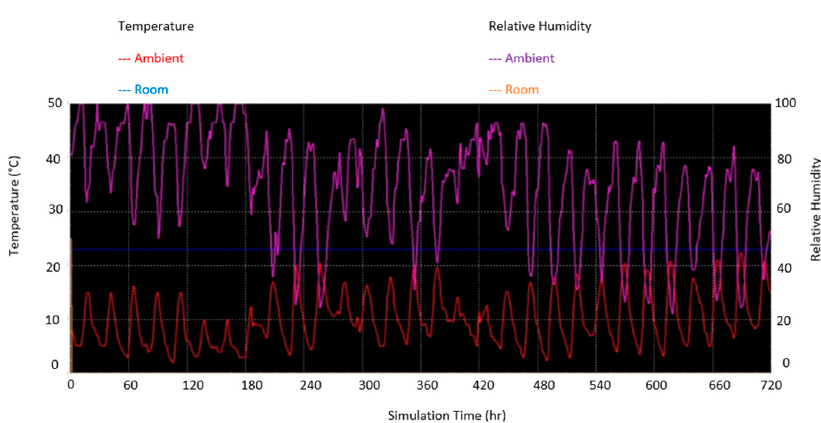
Figure 20. 1st January simulation run for option C.